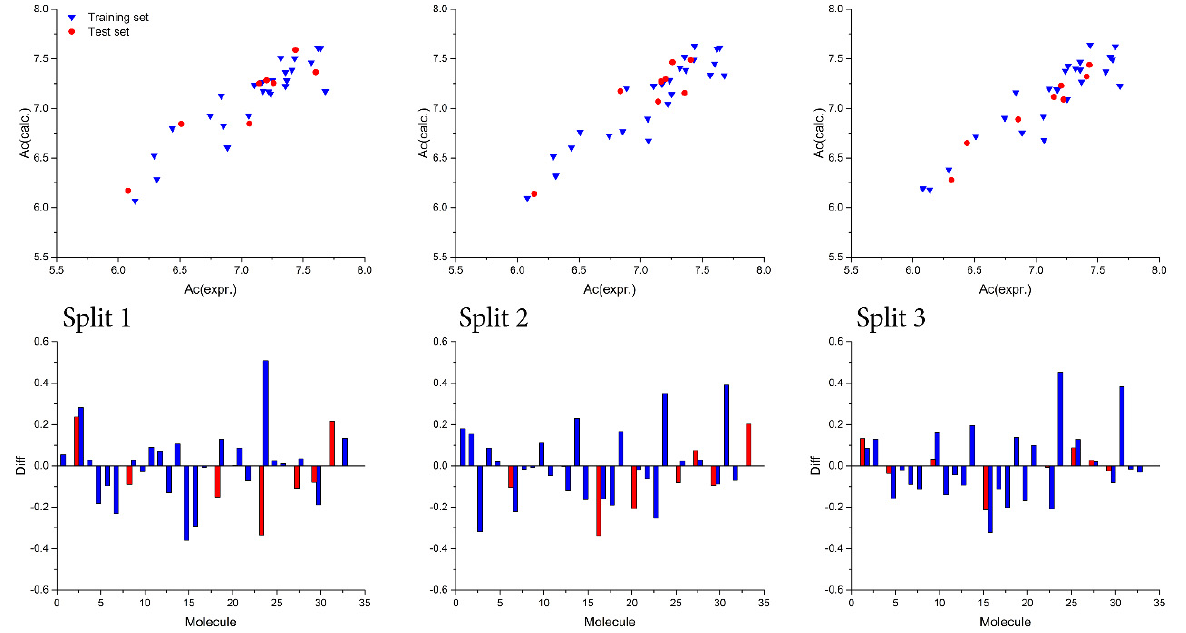
Figure 2. ( Above ): graphical representation of the best Monte Carlo optimization runs (the highest value for the r 2 ) for the developed QSAR models; ( Below ): difference between experimental and calculated values for pKi.